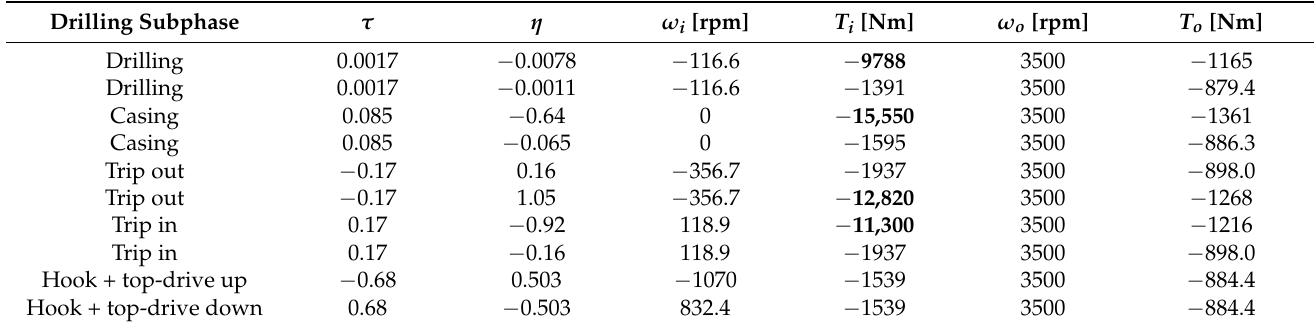
Table 4. MG I and MG O extreme operations for each drilling subphase with ICE working at 1400 rpm and 2080 Nm. MG I torque values exceeding the maximum torque of 4775 Nm are bolded.